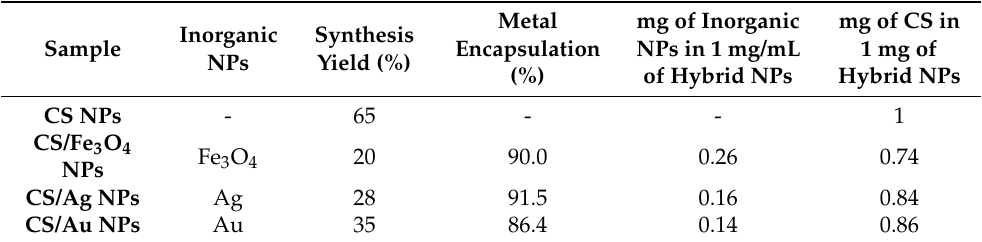
Table 2. Yields of ionotropic gelation-based syntheses of CS and CS-based hybrid NPs and their chemical composition